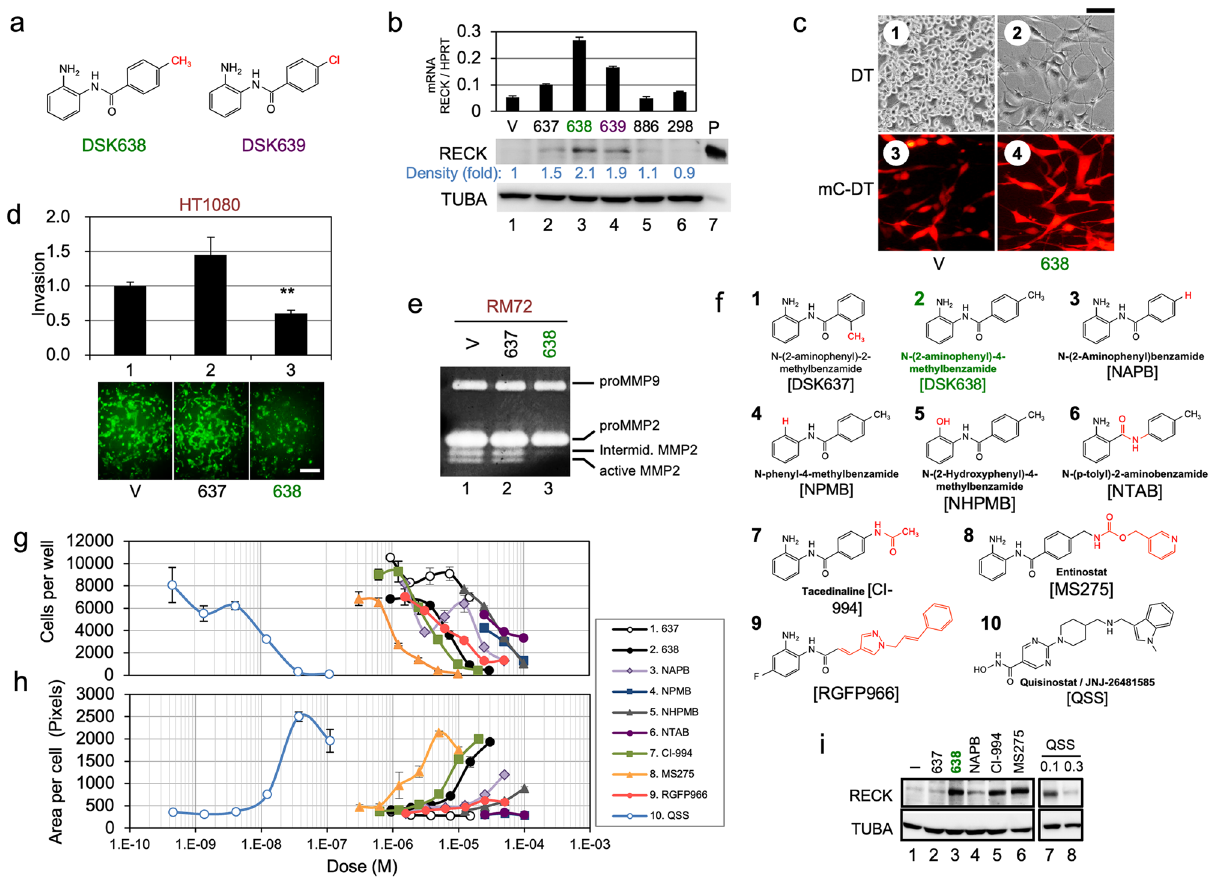
Figure 1. Detection and initial characterization of RECK -activating compounds. ( a ) Structures of two compounds exhibiting RECK -inducing activity. ( b ) Validation of RECK-inducing activities of five compounds selected by high throughput screening. HT1080 cells were exposed to vehicle (V) or a compound (code number) at 10 µM for 48 h. Total RNA and cell lysate were subjected to qRT-PCR (top bar graph) and immunoblot assay (bottom photographs), respectively, to detect RECK mRNA and RECK protein. qRT-PCR data were normalized against HPRT (internal control) and divided by the data for vehicle-treated samples (mean + s.e.m., n = 2). The number below the RECK immunoblot panel represents RECK band density normalized against α -tubulin (TUBA; internal control). ( c ) Flat reversion of v-K-ras -transformed cells by DSK638. The parental DT cells (1, 2) or DSK4b cells (mCherry-expressing DT cells) (3, 4) were incubated in medium containing vehicle (1, 3) or 10 µM DSK638 (2, 4) for 72 h and photographed under a phase-contrast (1, 2) or fluorescence (3, 4) microscope. Scale bar: 100 µm. ( d ) . Suppression of Matrigel invasion of HT1080 cells by DSK638. Cells pre-treated with vehicle (V), DSK637 (637), or DSK638 (638) were fluorescently labeled and subjected to Matrigel invasion assay in medium containing the same test compound. The relative number of cells that migrated across the Matrigel layer in 24 h (lower panels; scale bar: 200 µm.) were quantified by image analysis using ImageJ. The value relative to the vehicle-treated cells are presented in the top bar graph (mean + s.e.m., n = 4) ** P < 0.01. The experiments were repeated twice with similar results. ( e ) Suppression of proMMP2-activation by DSK638. Gelatin zymography was performed using culture supernatants prepared from RM72 cells treated with vehicle, 10 µM DSK637, or 10 µM DSK638. Note the substantially lower intensity of the bottom two bands, which correspond to intermediate and active MMP2, respectively. ( f ) Compounds tested by qRev assay. Abbreviations or short names are shown in parentheses. ( g, h ) qRev assay. DSK4b cells were exposed to the indicated drug at various concentrations for 60 h, and the relative numbers of nuclei (g) and the relative area per cell (h) were determined: experiments were performed in triplicate. ( i ) Effects of the compounds showing the highest activity in the qRev assay on RECK protein expression in HT1080 cells. HT1080 cells were exposed to medium (-) or the medium containing the indicated compound for 48 h, and the cell lysates were subjected to immunoblot assay to detect RECK (upper panel) and α -tubulin (lower panel). The concentration of each drug was 10 µM except for QSS whose concentrations were 0.1 µM (lane 12) and 0.3 µM (lane